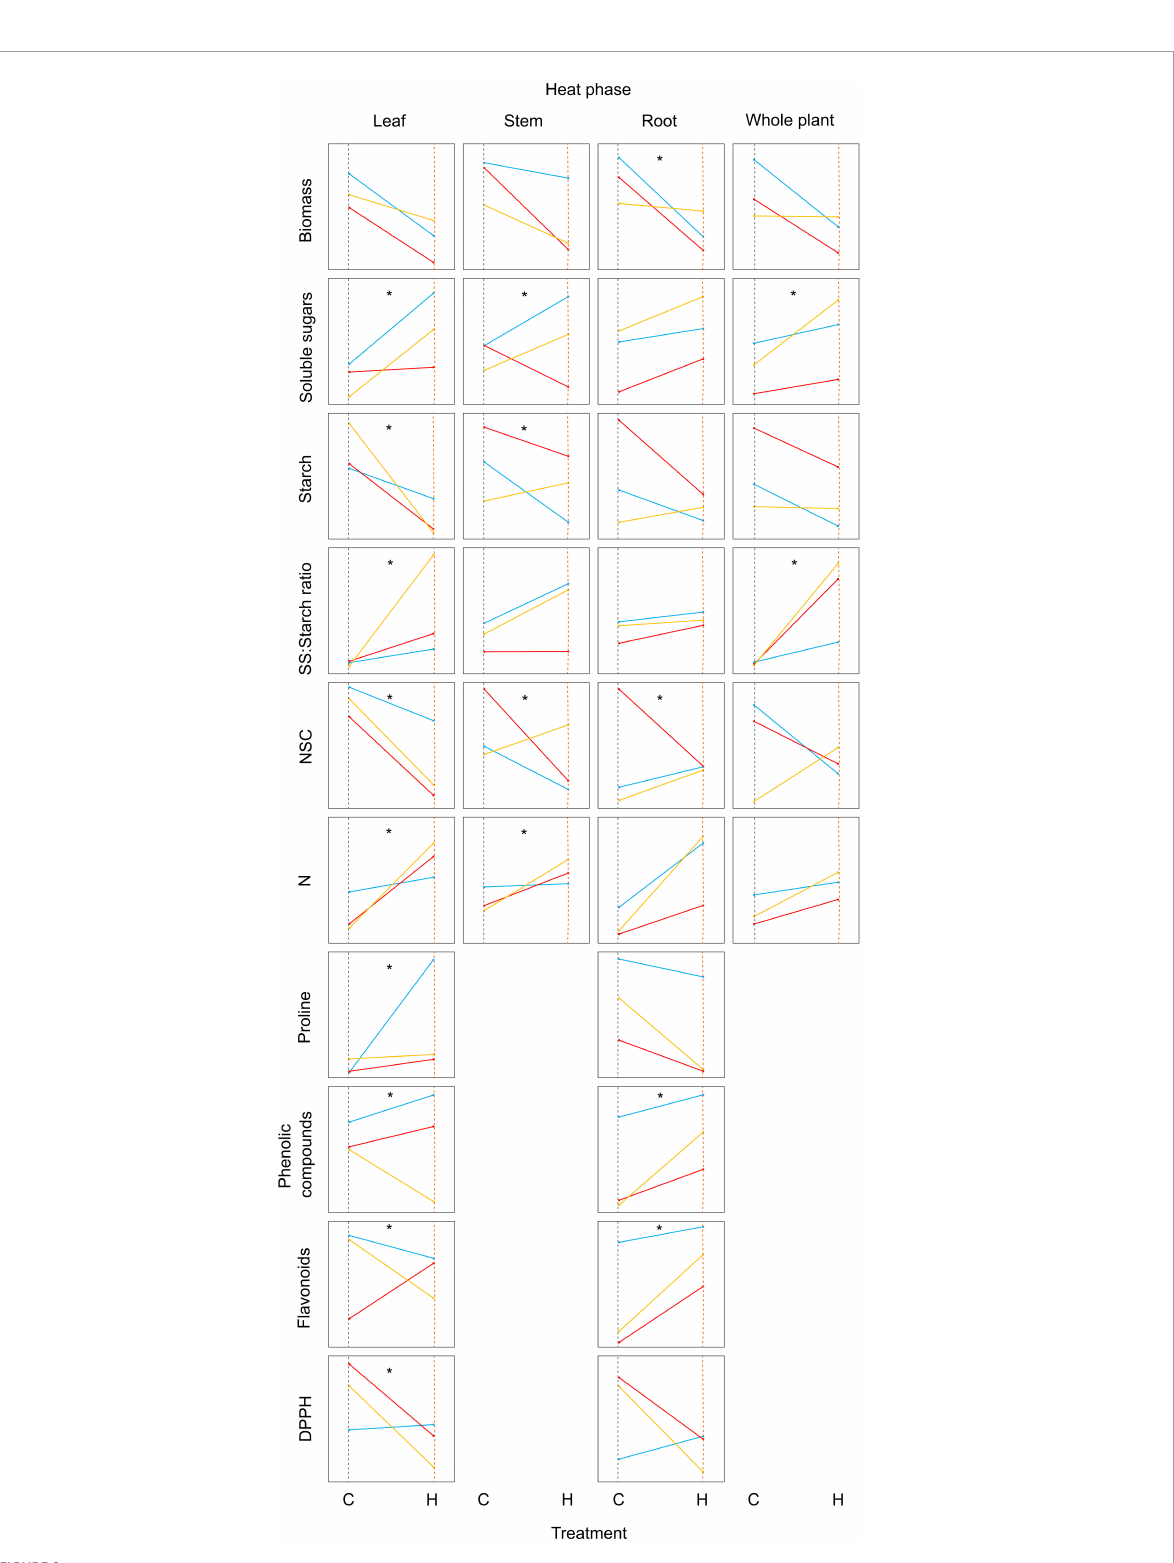
Frontiers in Forests and Global